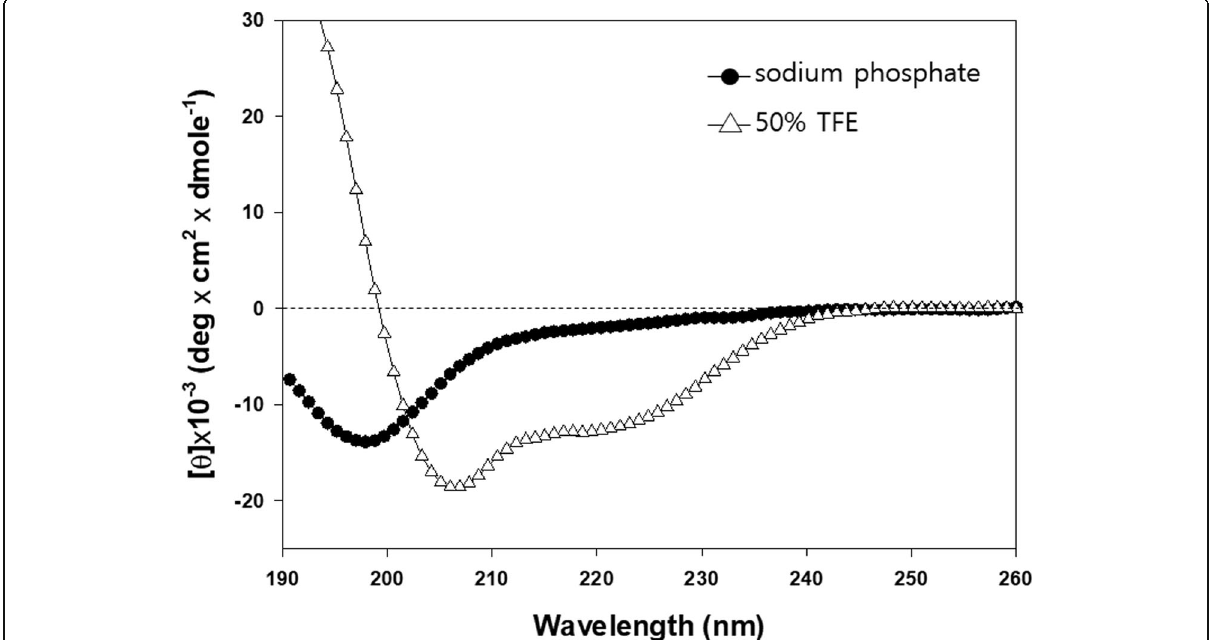
Fig. 2 CD spectra of KR-12-pa in a 50-mM sodium phosphate (pH 6.5) (filled circles) and 50% TFE (open triangles). The mean residue ellipticity was plotted against wavelength. The values from three scans were averaged per